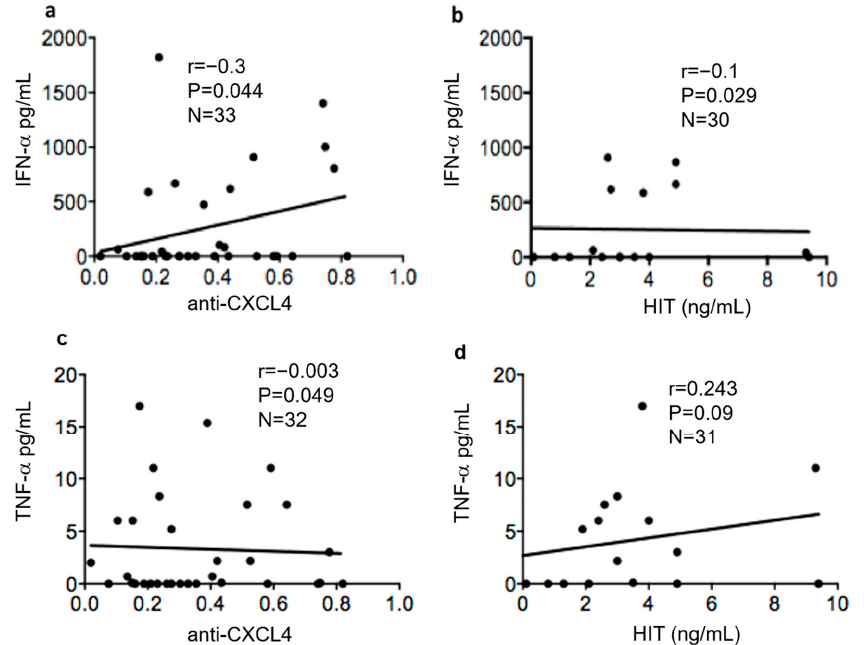
Figure 3. HIT antibodies do not correlate with IFN- α in plasma. Plasma of SSc was assessed for the positivity for IFN- α and TNF- α by ELISA (see methods). Values of IFN- α and TNF- α concentrations were plotted against values of anti-CXCL4 positivity ( a , c ) or amounts of HIT antibodies ( b , d ). Spear- man’s correlation test was used to address correlation between these antibody types and IFN- α . The “r” coefficient of correlation, p (significance) and N (sample size) are reported on each